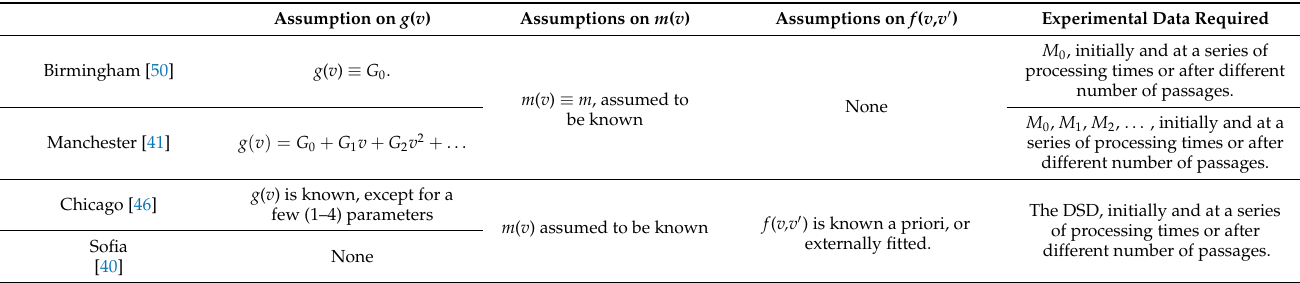
Table 1. Assumptions imposed and experimental data required by the four investigated methods for estimating fragmenta- tion rates from emulsification